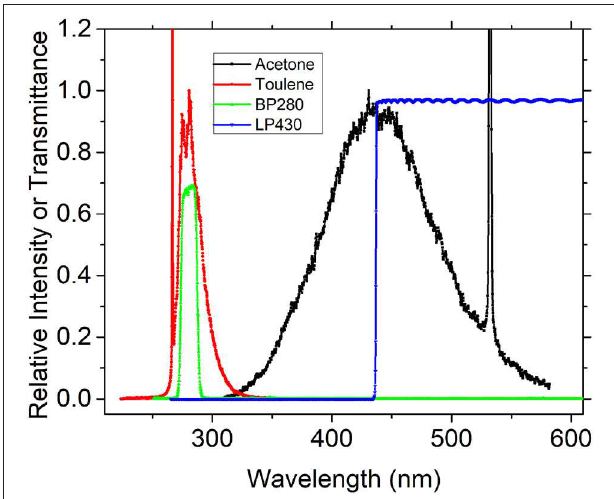
FIGURE 3 | Fluorescence spectra of toluene (red) and acetone (black) in nitrogen excited by 266nm pulsed and transmission spectrum of Semrock BP280 (green) and LP430 (blue).